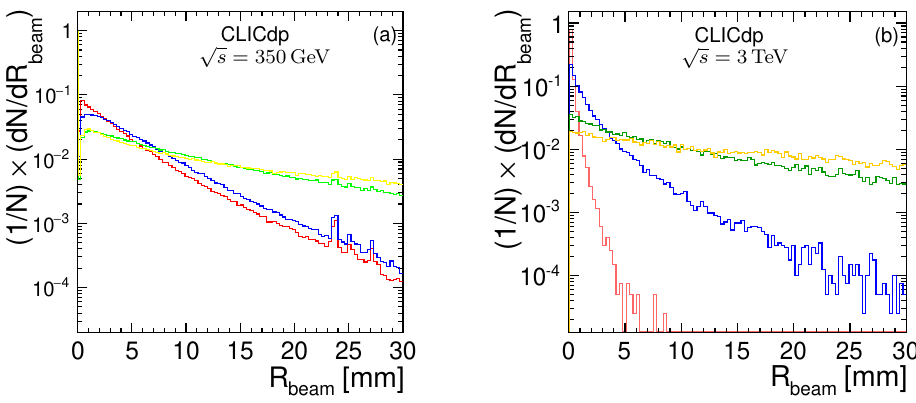
Figure 1 . Radial distance of the generated π 0 to the beam axis for π 0 v of 50 GeV/c 2 and with four different lifetimes: 1 ps (red), 10 ps (blue), 100 ps (green) and 300 ps √ √ (yellow) [25] for (a) s = 350 GeV and (b) s = 3